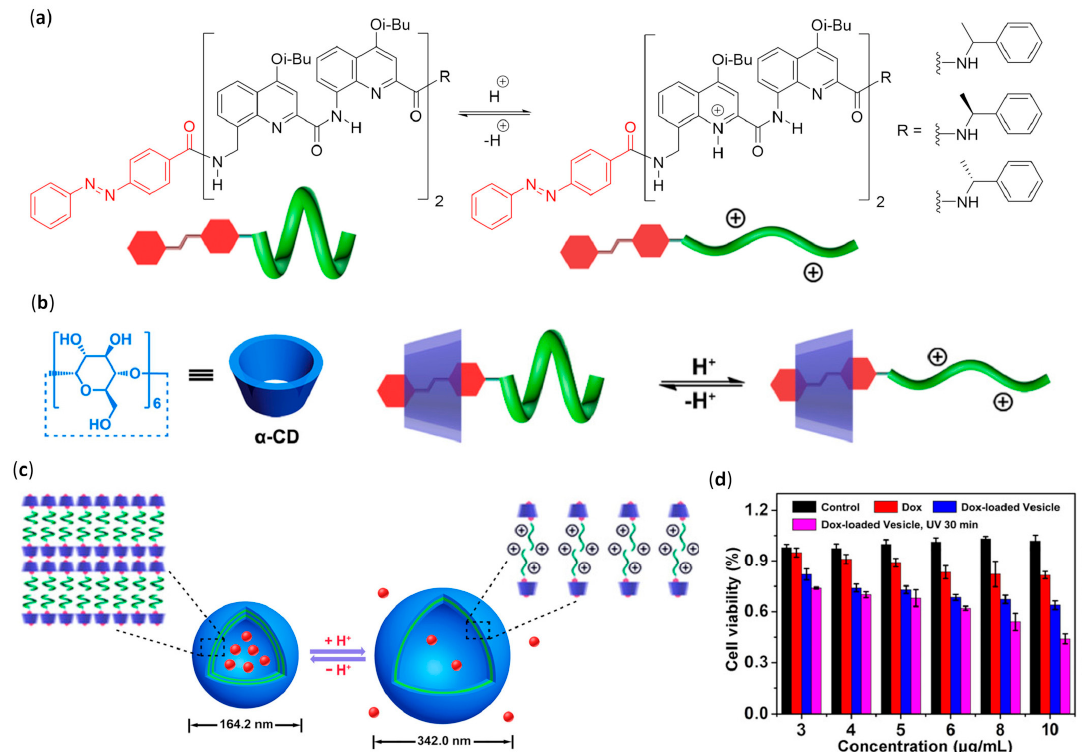
Figure 15. ( a ) Acidification-driven unfolding of a foldamer based on 8-amino and 8-aminometyl-2- quinoline carboxylic acid (Ref. [180]) alternating units (green), having an N-terminal azobenzene group (red) (adapted with permission from Ref. [178]); ( b ) Folding / unfolding equilibrium of host–guest complexes with α -cyclodextrin (cyan) (adapted with permission from Ref. [178]); ( c ) Morphological changes of vesicles triggered by pH variations (adapted with permission from Ref. [178]); ( d ) MCF-7 cancer cells viability upon incubation with free vesicles (black), doxorubicin (red), doxorubicin-loaded vesicles with (fuchsia) and without (blue) UV light irradiation, respectively, as a function of DOX concentration (adapted with permission from Ref. [178]).